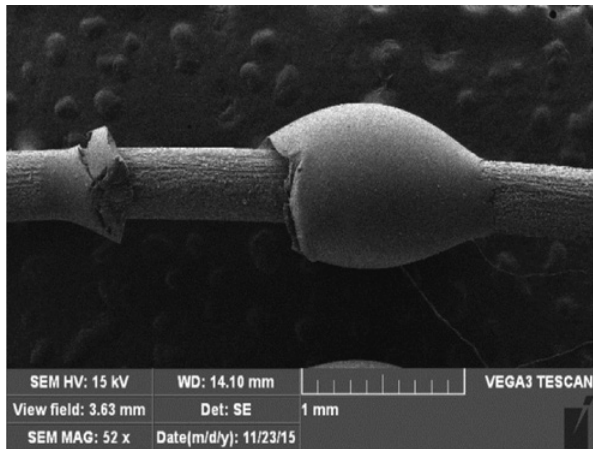
Figure 11: Micrograph of debonded epoxy microdroplet on a treated fiber